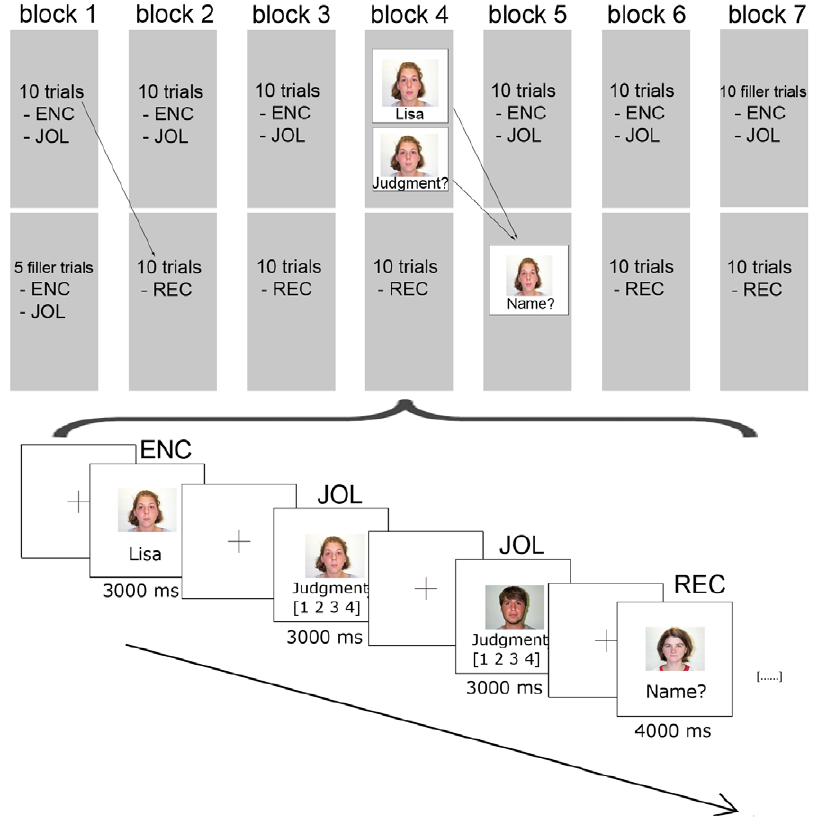
Figure 1. Experimental design. Overview of the experimental design which consisted of seven blocks. Encoding (ENC) and JOL trials in the first phase of each block were followed by a phase with recall trials. Sample encoding trials, JOL trials, and recall (REC) trials. Encoding and JOL trials were presented for 3000 ms, recall trials for 4000 ms, ISI varied from 2400 ms to 4200 ms. For each face with the caption ‘‘Judgment?’’, participants provided a judgment of learning. For each face with the caption ‘‘Name?’’, the previously presented name had to be recalled.